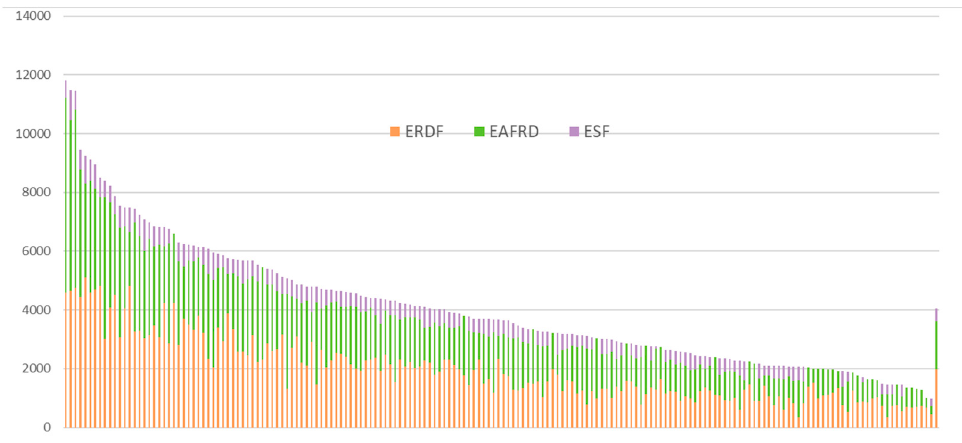
Figure 9. Budgets of the 178 multi-funded LAGs in Czechia 2014–2020, by ESI fund, in EUR 1000 [9] Data from Czech programme authorities. Note—country average on the right.